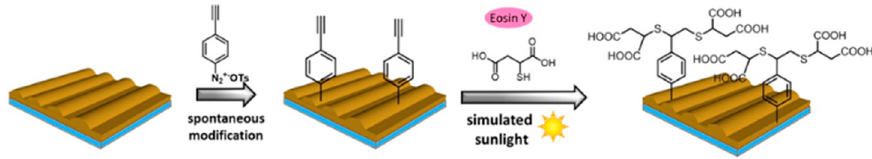
Figure 1. Preparation of gold gratings grafted with mercaptosuccinic acid via thiol–yne reaction under simulated sunlight irradiation.